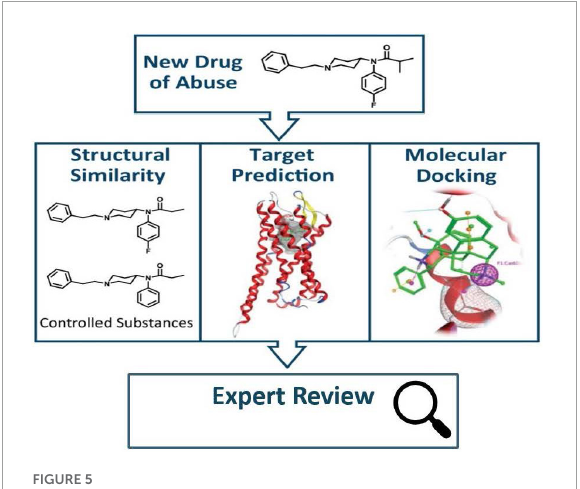
FIGURE5 When a new drug of abuse is identified, public health assessment via structural evaluation (PHASE) uses chemical structure to assess the new drug’s risk to public safety